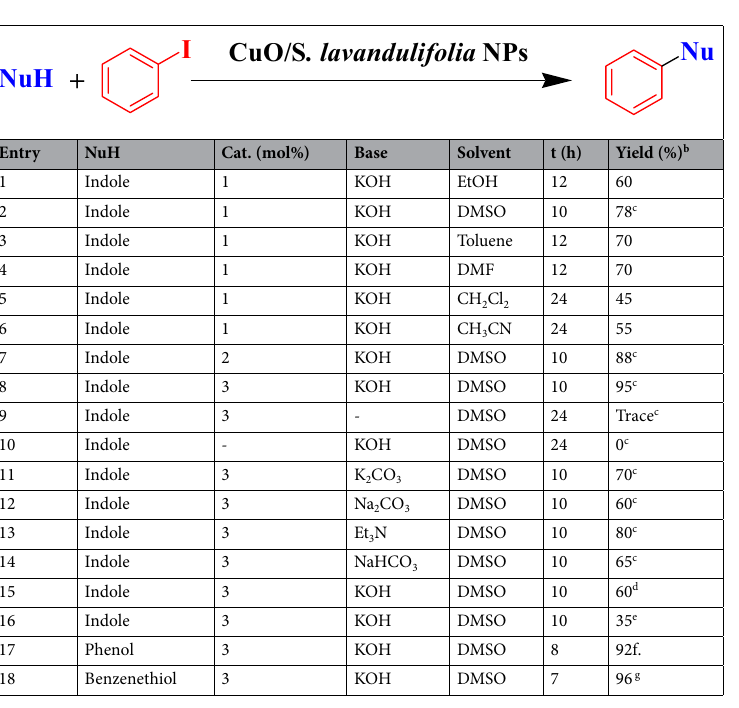
Table 1. Optimization of reaction condition for CuO/ S. lavandulifolia NPs -catalyzed coupling of indole/ phenol/benzenethiol with iodobenzene. Reaction conditions: N/O/S nucleophile (1.0 mmol), iodobenzene (1.1 mmol), CuO/ S. lavandulifolia NPs, base (1.5 mmol), solvent (3.0 mL),N 2 atmosphere; b Isolated yield; c 100 °C; d 70 °C; e 25